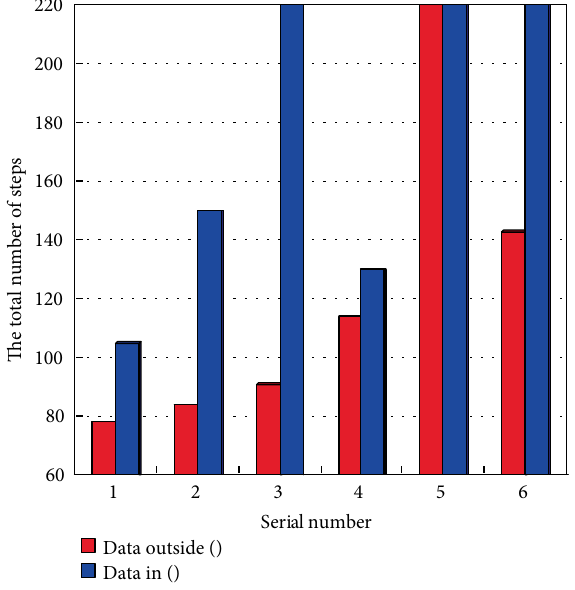
Figure 12: A comparison chart of 𝑠 sum when there are 3 or more obstacles.